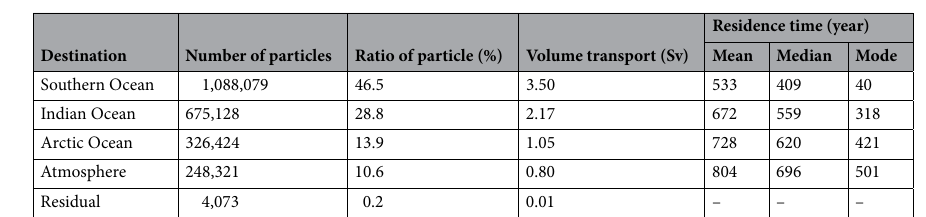
Table 1. Number and ratio of particles, volume transport, and residence time of particles for each destination. The mean, median, and mode are listed for the residence time. The result is obtained from the tracking for 3000 years. The total number of particles is